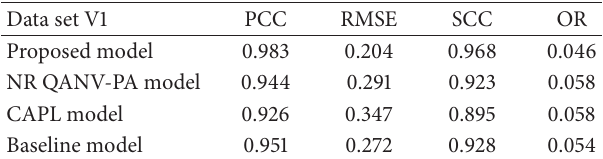
Table 8: Performance comparison between objective data and subjective data.